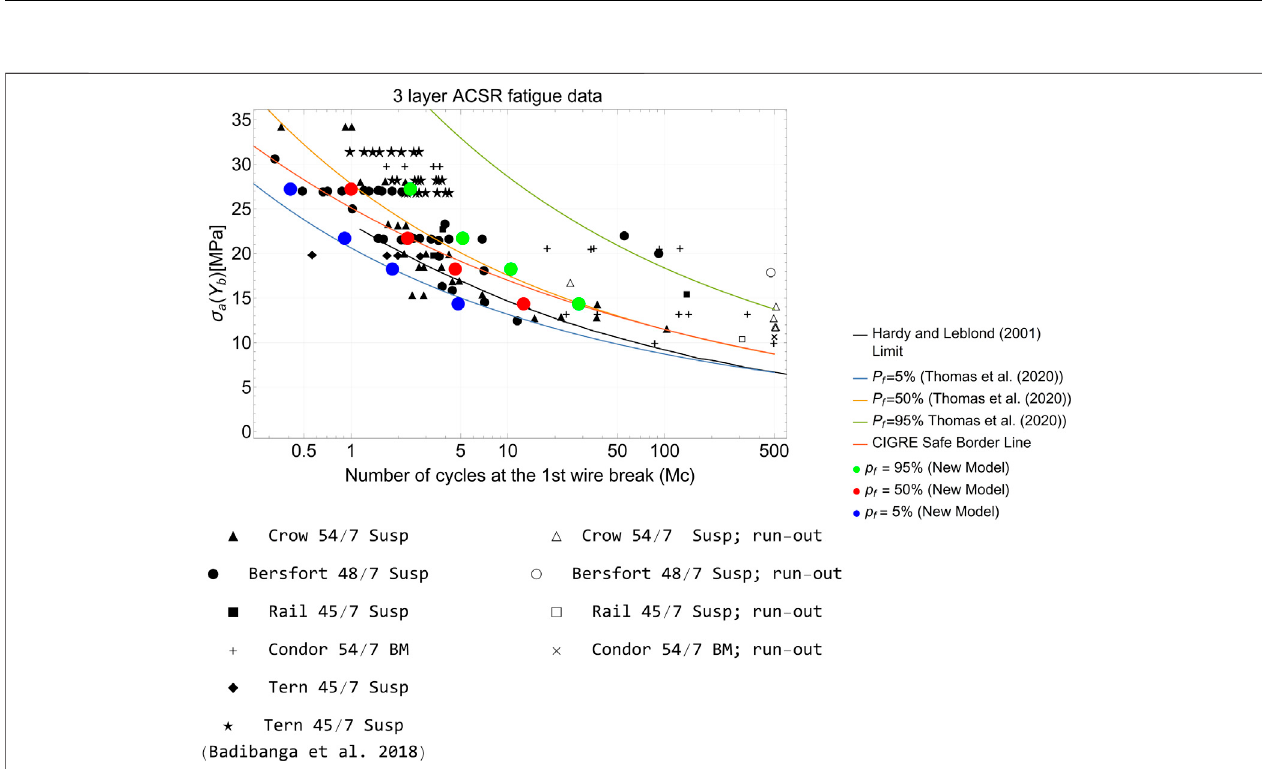
FIGURE 17 | A comparison of the stress – life curves derived from the proposed framework for fi rst wire failure with previous models. All black data points are from Cloutier et al. (2006) except otherwise stated.